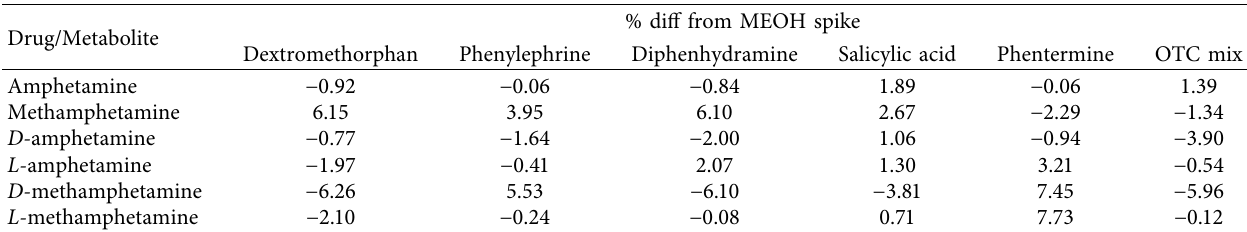
Table 10: Concomitant medications: the indicated medications prepared in methanol were spiked into a QC 7.5 standard and measured. Te data indicates percent diference from a QC standard spiked with blank methanol at the same volume as the drug standards.